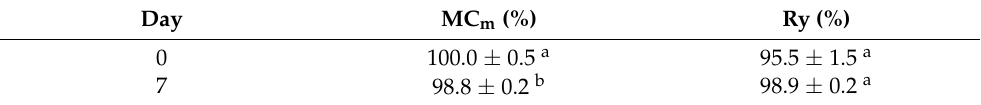
Table 1. Marker concentration measurable (MC m ) and recovery yield (Ry) for the marker (tartrazine) in the aqueous phase recovered standard where 100% of the marker is in the outer aqueous phase (W 2 ). Different letters within a row indicate significant differences ( p <